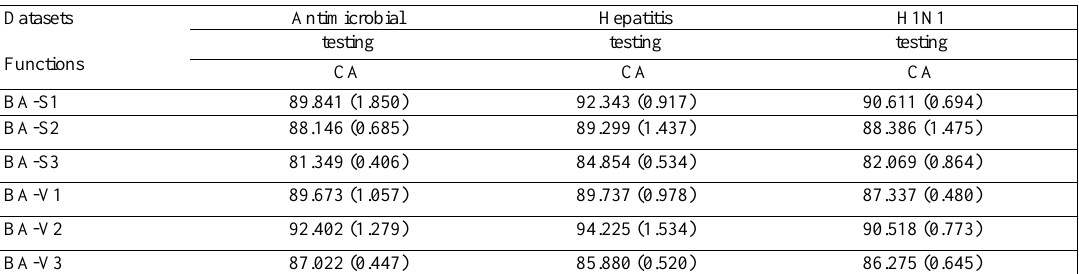
Table 3. Methods performance evaluation (on average) according to the testing datasets with the standard deviation is between